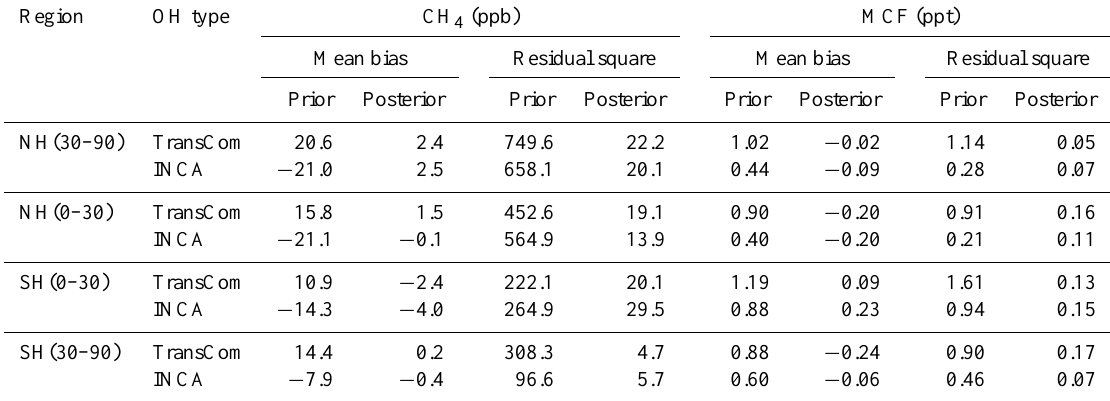
Table 3. Fitness of CH 4 and MCF observations assimilated in the inversion. Region OH type CH 4 (ppb) MCF (ppt) Mean bias Residual square Mean bias Residual square Prior Posterior Prior Posterior Prior